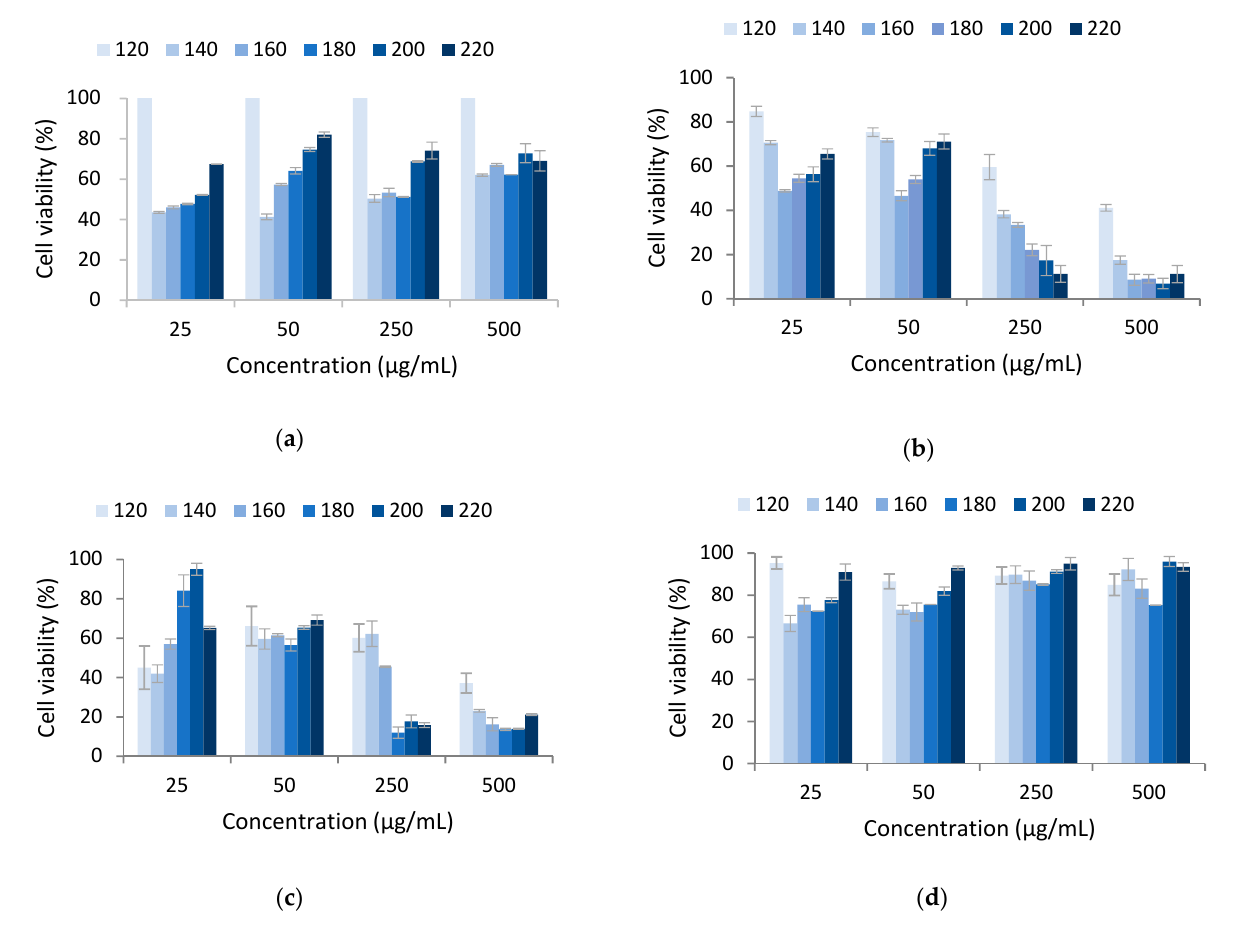
Figure 6. Cell viability of selected human tumoral cells in contact with the liquid phases obtained after autohydrolysis at different final temperatures from 120 to 220 °C for the cell lines: A549 ( a ), HCT-116 ( b ), PSN1 ( c ), and TG98 ( d ). When standard deviations were lower than the symbol size, it was not plotted in the corresponding graph.